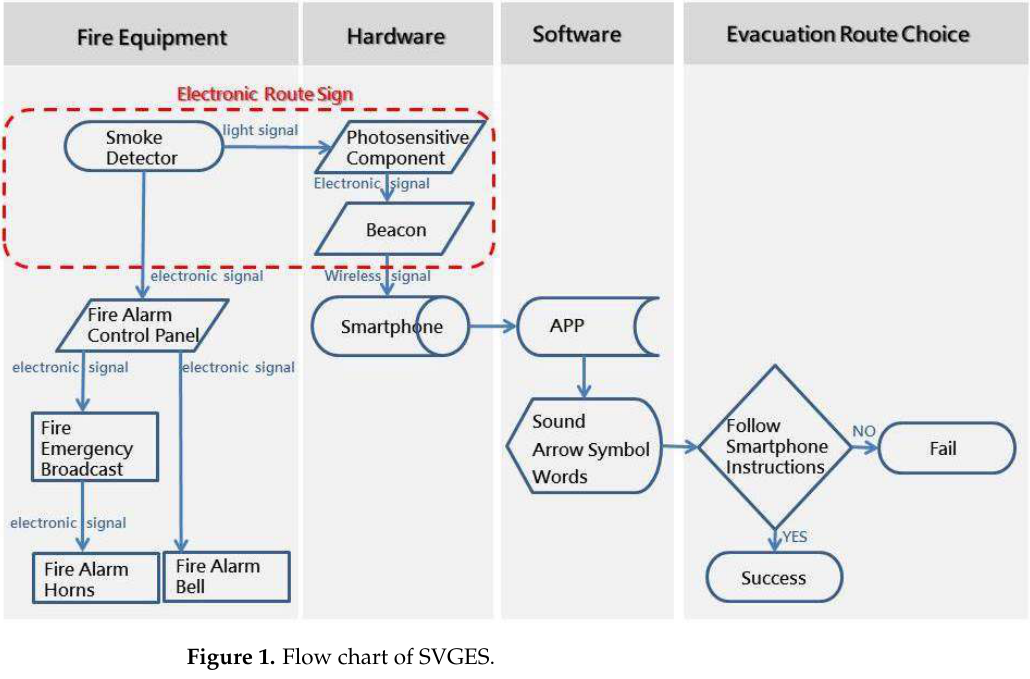
Figure 1. Flow chart of SVGES.